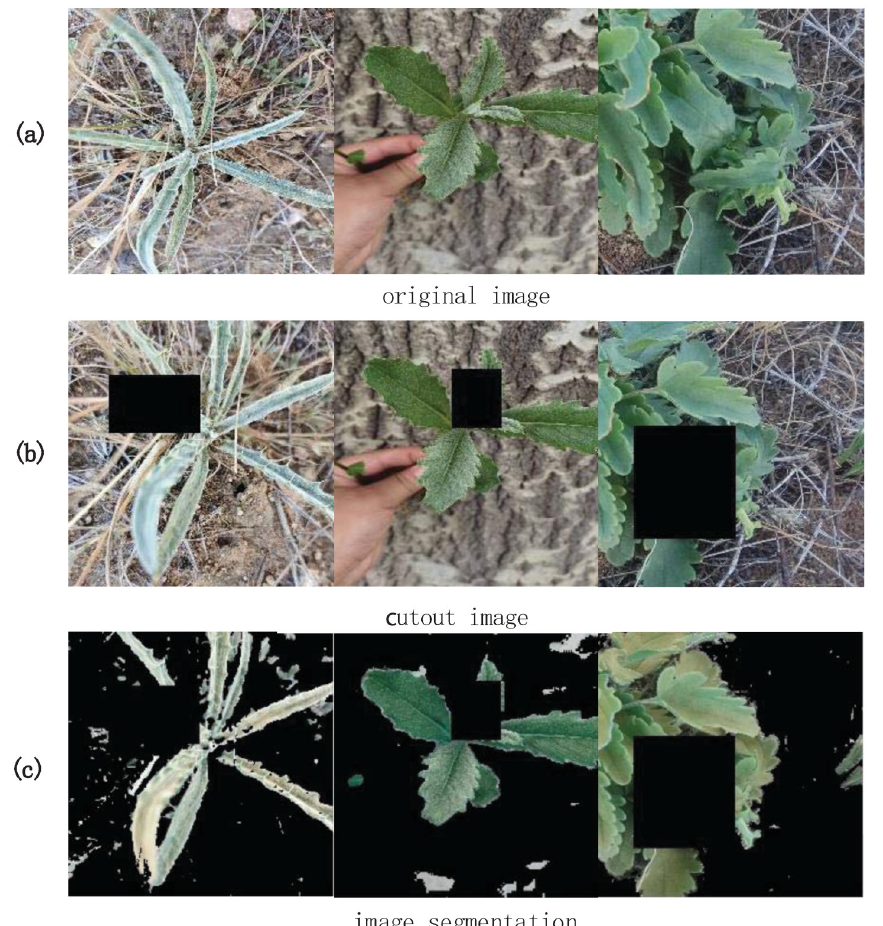
Fig 6. Data processing results: The first row is the original data, the second is the cutout enhanced data, and the third is the background segmentation data.